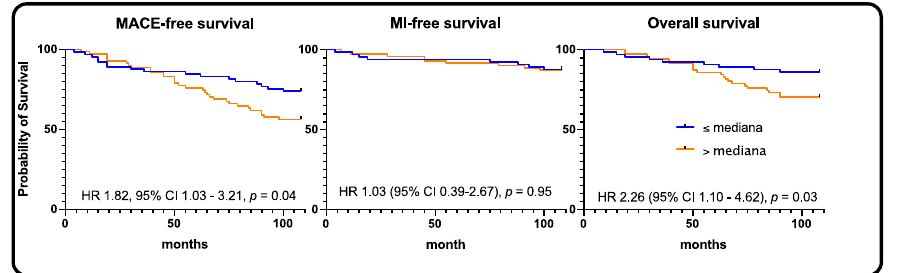
Figure 5. SYNTAX 0–22 population—Kaplan–Meier curves for MACE, myocardial infarction, and